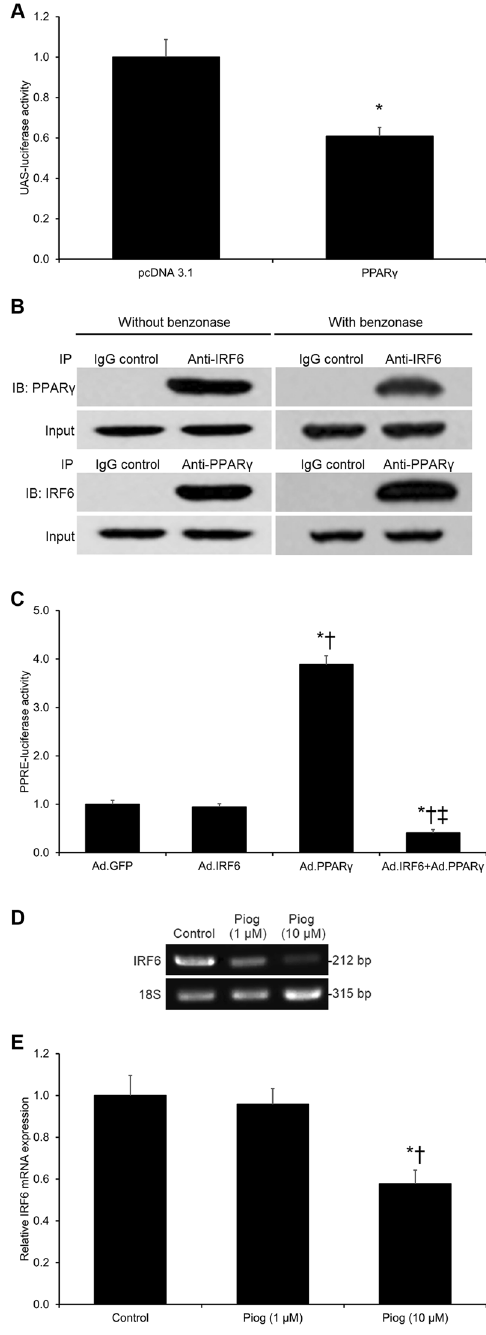
Figure 1. IRF6 Identified as a PPAR γ Co-Regulator in Cerebrovascular Endothelial Cells. ( A ) A luciferase reporter assay was performed by co-transfecting HEK293 cells with UAS-Luc, PPAR γ , and IRF6-Gal4-DBD vectors. * P < 0.05 versus pcDNA 3.1 group. ( B ) Co-immunoprecipitation (IP) assays on the total protein content from murine cerebrovascular endothelial cells revealed that IRF6 directly binds to PPAR γ . Treatment with benzonase did not significantly affect IRF6-PPAR γ binding. Cropped blots are displayed here. ( C ) PPRE transcriptional activity was assayed in murine cerebrovascular endothelial cells co-transfected with an adenoviral IRF6 vector and the 3 × PPRE-Luc vector in the presence of an adenoviral PPAR γ vector or a GFP vector. Although IRF6 did not significantly affect PPRE activity at basal levels, IRF6 did significantly inhibit PPAR γ -driven PPRE transcriptional activity. * P < 0.05 versus Ad.GFP group, † P < 0.05 versus Ad.IRF6 group, ‡ P < 0.05 versus Ad.PPAR γ group. ( D,E ) Real-time PCR on the total RNA content from murine cerebrovascular endothelial cells treated with pioglitazone revealed that PPAR γ activation by pioglitazone (10 µ M) significantly inhibits IRF6 mRNA expression. Cropped blots are displayed here. * P < 0.05 versus Control group, † P < 0.05 versus Pioglitazone (1 µ M) group. Data are reported as means ± standard errors of the mean